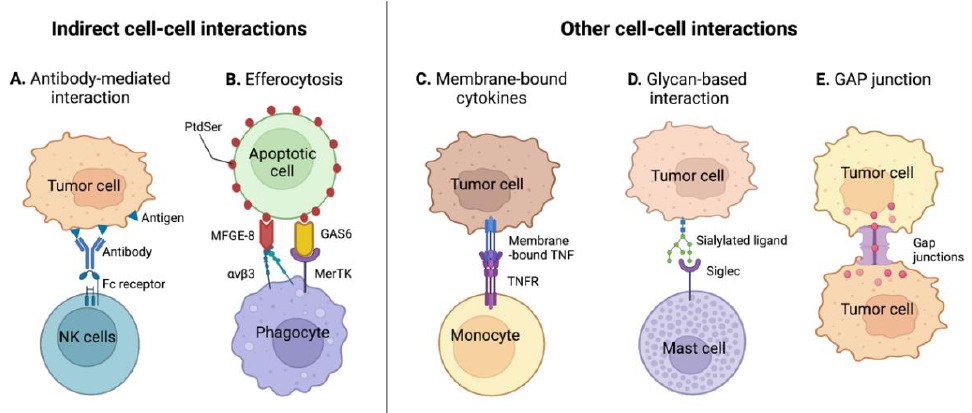
Figure 4. Indirect cell-cell receptor interactions and other types of molecular interactions modulating immune responses in the TME. ( A ) Antibody-dependent interaction between tumor antigens and Fc receptors of immune cells. ( B ) Recognition of PtdSer by phagocytes via the bridge proteins MFGE-8 and GAS6. ( C ) Direct cell-cell interaction via membrane-bound cytokines. ( D ) Cell-cell interaction via glycan recognition. ( E ) Cell-cell interaction via proteins involved in cellular communication (e.g., gap junction).